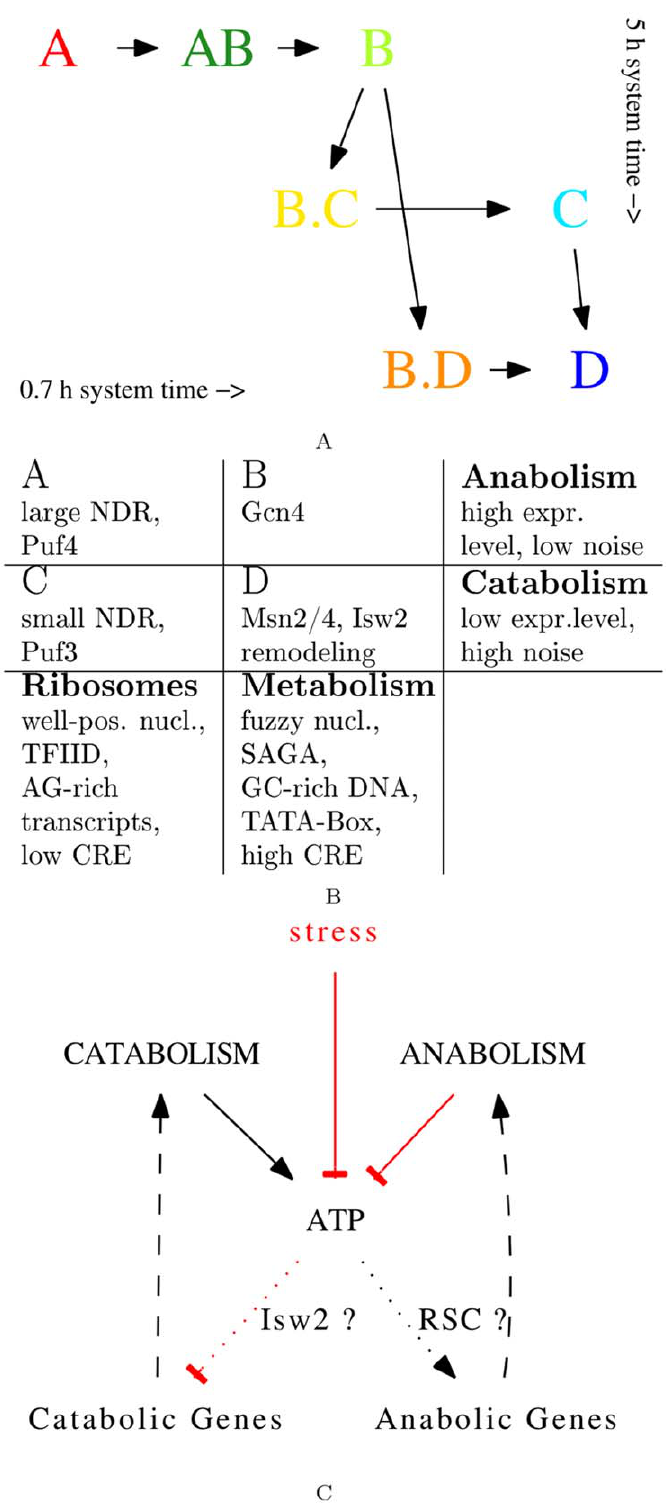
Figure 8. Nucleotide content & invitro nucleosome occupancy. Figure 1C provides a color legend. 8A & 8B: local GC- and purine frequencies were first calculated for each gene and each position in sliding windows (size: 71 nt.), and then SDP were constructed using t -tests for statistics visualization. Tests were performed without prior binning of values, and instead values are shown only for each 10 th nucleotide position for visual clarity. 8C: in vitro nucleosome reconstitution at low histone levels [37], 1 bp resolution, SDP with bin size 10 bp and Mann-Whitney-Wilcoxon tests. Background clusters are shown in Figure S20.